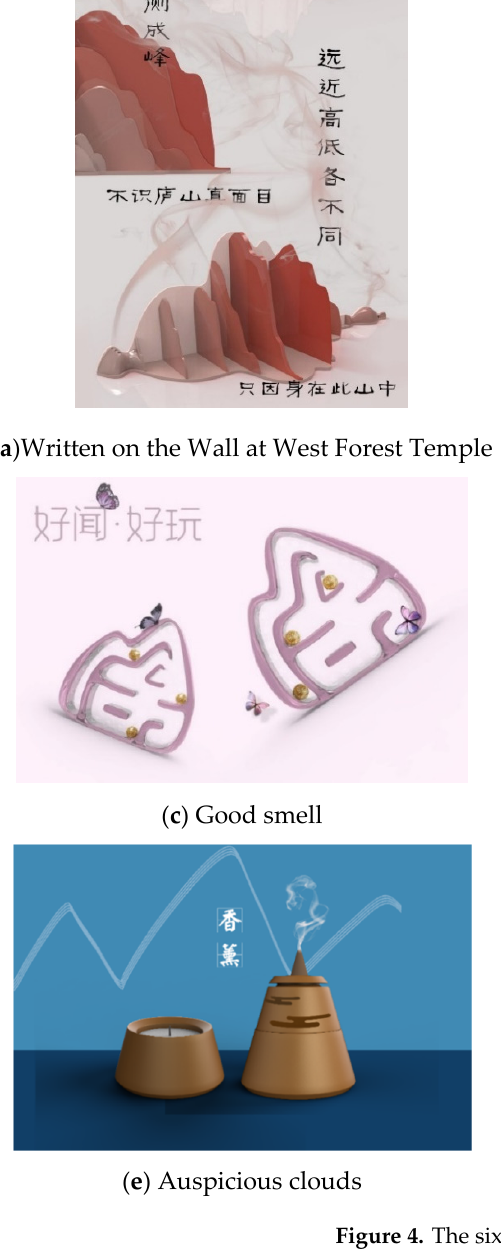
Figure 4. The six evaluated designs.